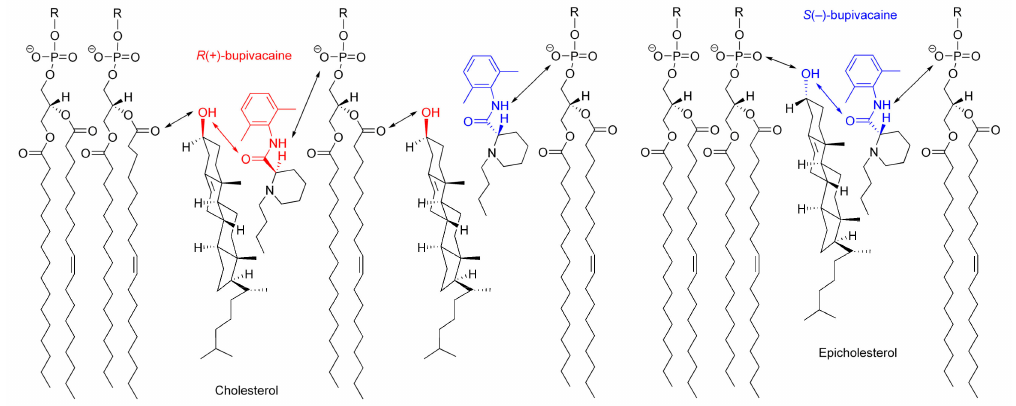
Figure 8. Possible interactions of bupivacaine enantiomers with cholesterol-containing